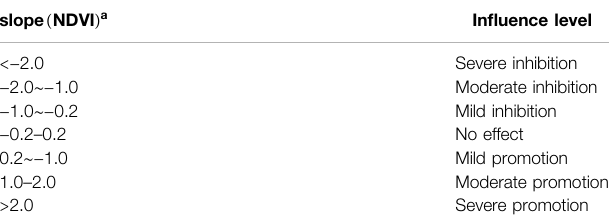
TABLE 1 | Classi fi cation of the impacts of climate change and human activities on vegetation restoration (10 – 3 a − 1 ). slope ( NDVI ) a In fl uence level < − 2.0